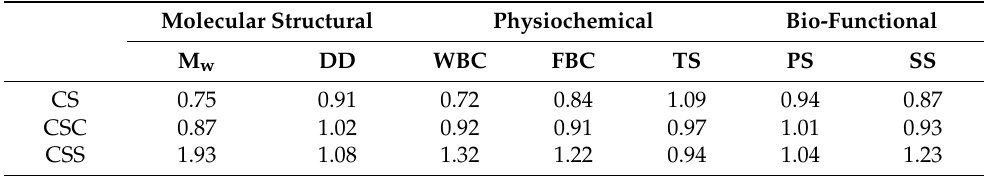
Table 8. The index value after standard normalization.